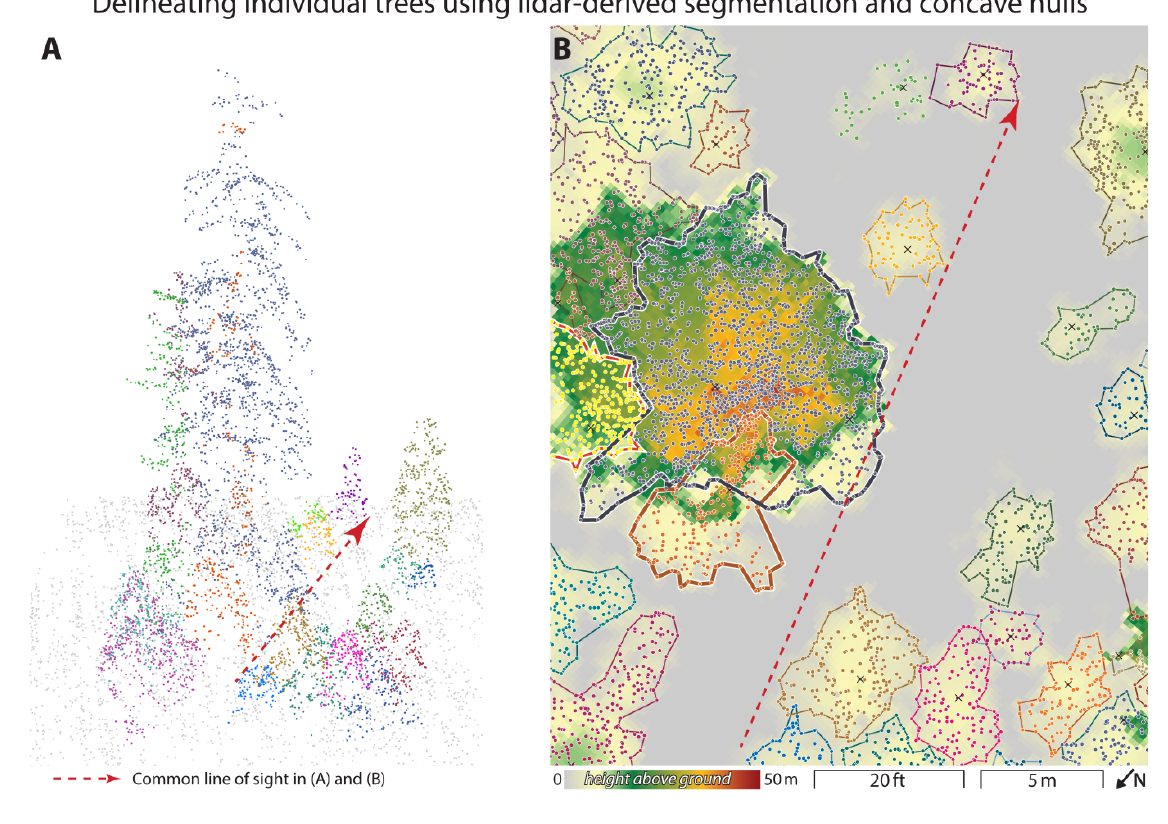
Figure 4. The normalized lidar point cloud was segmented into individual trees using 3D point classification algorithm ( A ). The classified points were delineated using concave hull in the x-y space ( B ). The thicker tree boundaries exemplify that the lidar-segmentation algorithm allows for polygons to overlap. The lidar points are identically color-coded by individual trees in both